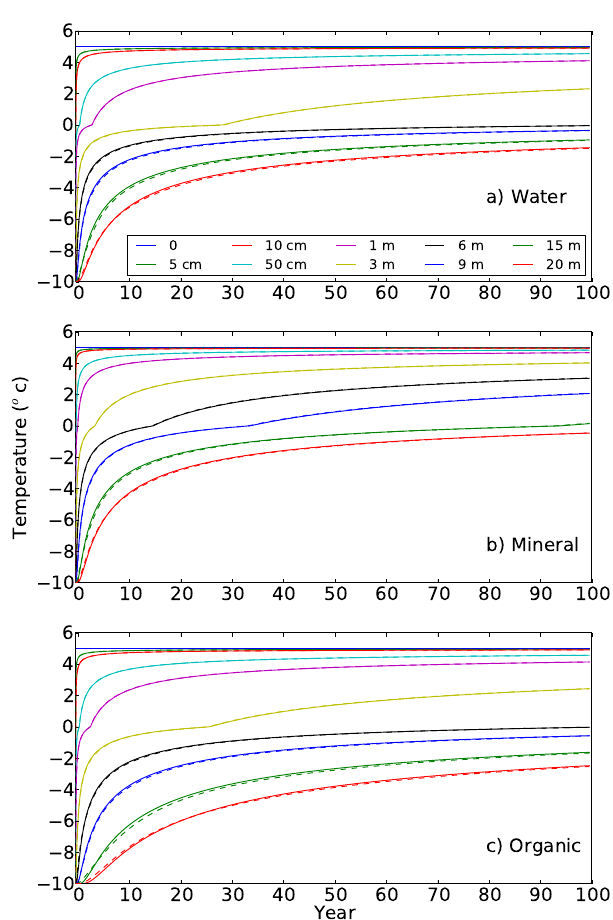
Figure 4. Comparisons of outputs from DOS-TEM simulations (dashed lines) and exact Neumann solutions (solid lines) for (a) wa- ter, (b) mineral soil, and (c) organic soil over a period of 100 years, at depths from 0 to 20 m.